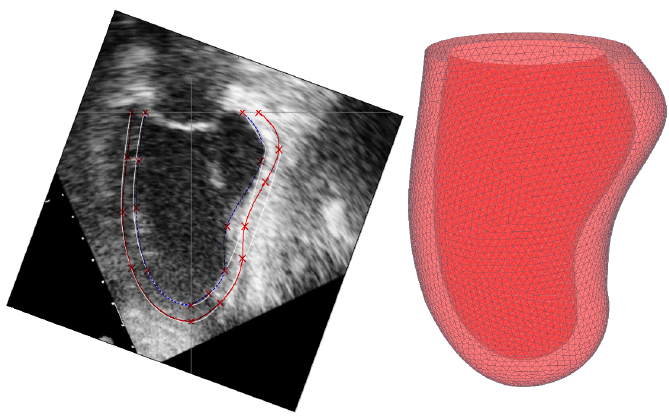
Figure 14. Ultrasound imaging as a base for model construction. ( left ) A sonographic two-chamber view of a patient’s heart and two measurements: the first for the power-function-based model (white lines) and the second for the spline-based model (blue lines show the endocardium; red lines show the epicardium). The patient suffered from an old myocardial infarction, and a scar is present. The marked points are shown as crosses. This view gives data for two model meridians. The model axis and base are shown as grey lines. The image has been rotated so that the model axis Oz is vertical. ( right ) A spline-based model of this patient’s LV. The view is semitransparent to show both the epicardial and endocardial surfaces. The surface mesh was made using Ani3D-AFT software